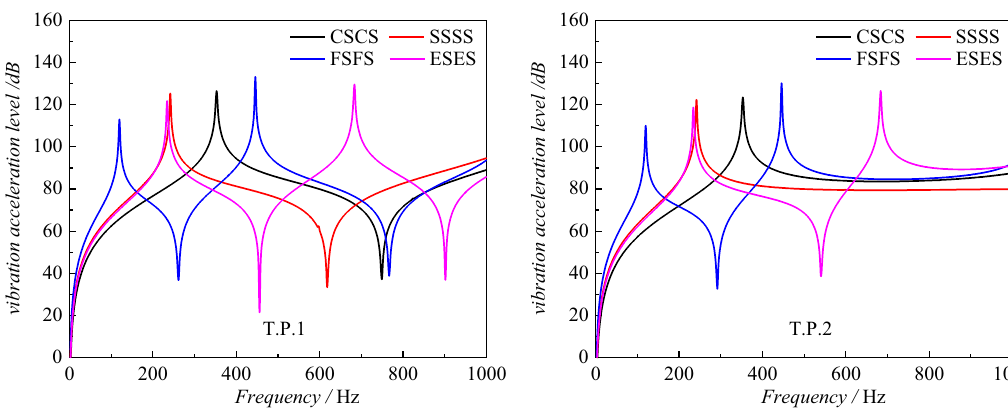
Figure 10: Comparison of the steady vibration of rectangular plate with di ff erent boundary conditions.